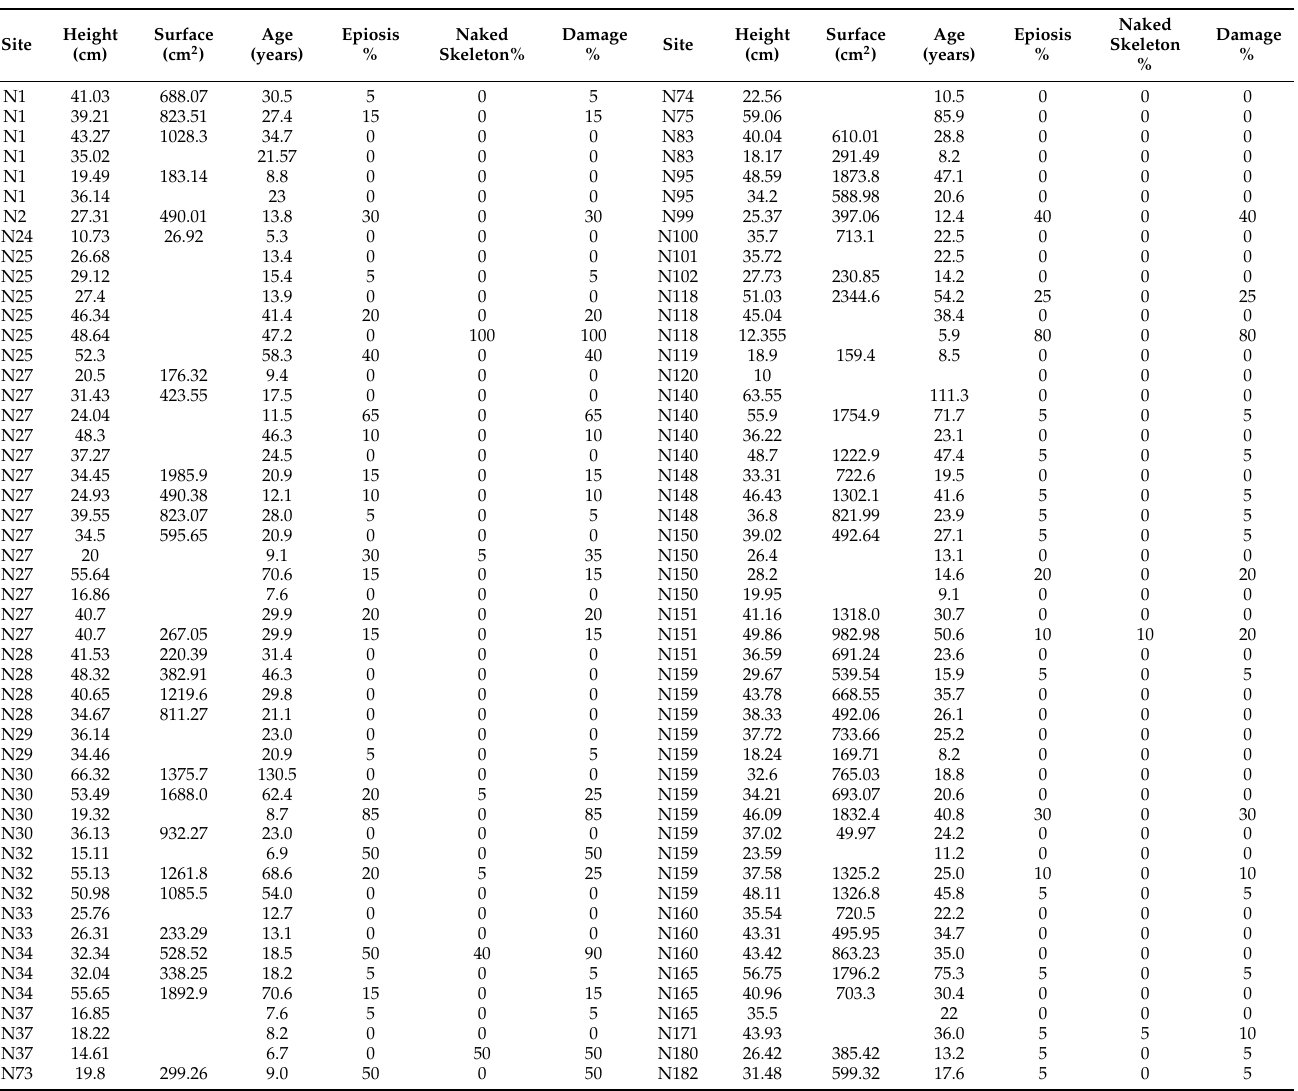
Table 2. Morphometric parameters, percent portion of surface covered by epibionts, naked skeleton and damage of the specimens of Eunicella verrucosa investigated in the present